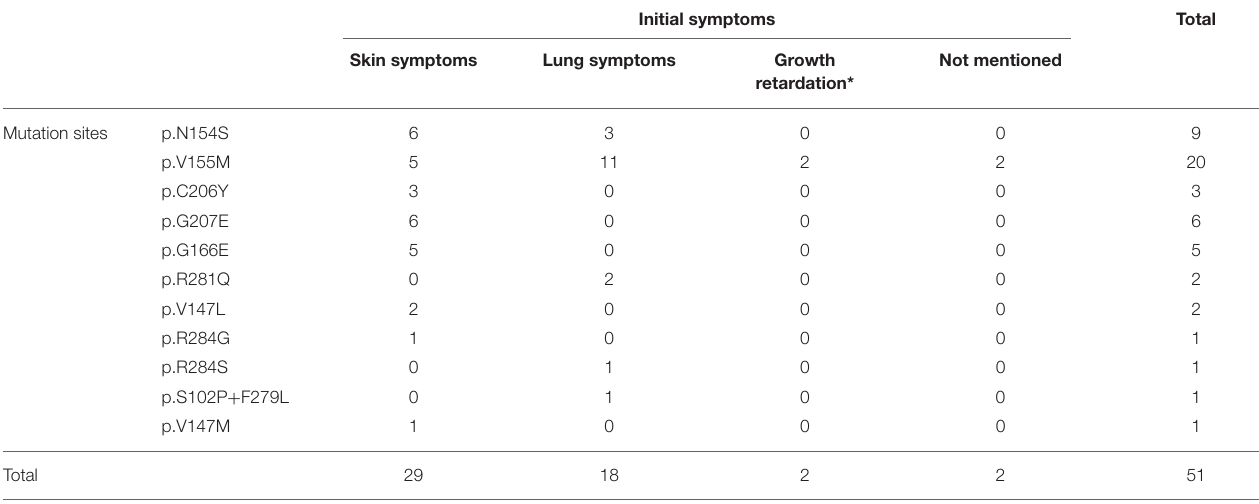
TABLE 3 | Initial symptoms of the different genotypes.